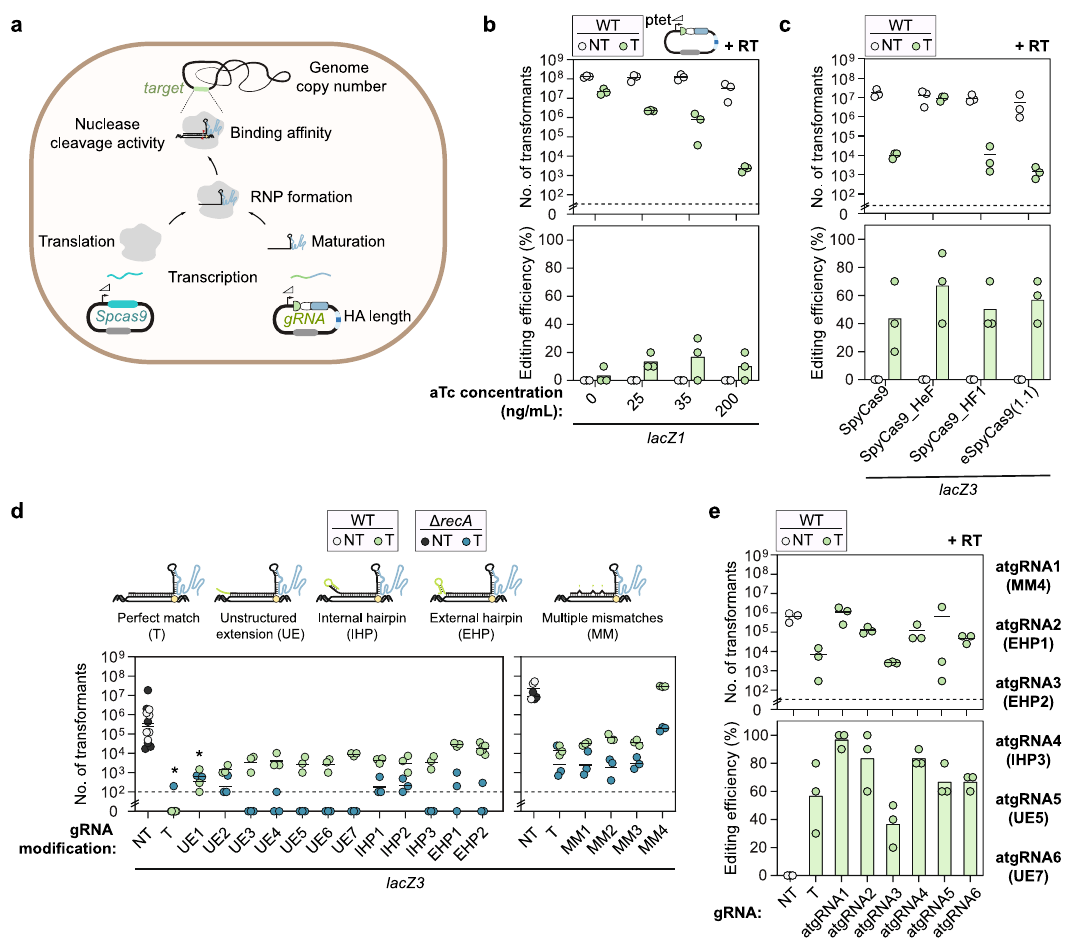
Fig. 2 | Modulating DNA targeting activity, including through attenuated gRNAs, can boost colony counts without sacri fi cing editing ef fi ciencies. a Schematic of different steps that can be altered to attenuate DNA targeting to improve homologous recombination with a supplied RT. The maturation step applies onlyto crRNAs. b Genome editing assayin E.coli with aTcinduciblesgRNA expression. A non-selective out-growth with aTc induction was used prior to selective plating. c Genome editing assay in E. coli using WT, HeF, HF1, and e(1.1) SpyCas9. d) Genome targeting assay in E. coli and E. coli Δ recA with modi fi ed sgRNAs and Cas9. e Genome editing assay in E. coli using selected attenuated gRNAs(atgRNAs)fromd.CellsweremadeelectrocompetentatABS 600 ≈ 1.4 − 1.6for theeditingassay.Individualdotsforthetransformationsindicateasinglebiological